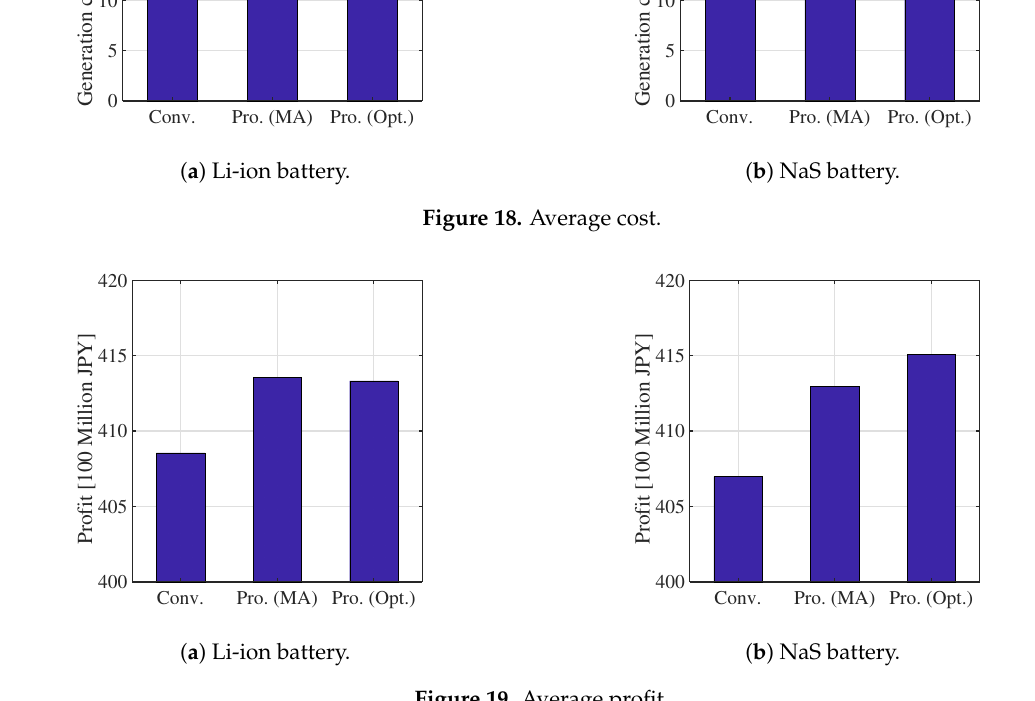
Figure 19. Average profit. Table 7. Average of simulation results. Conv. Pro. (MA) Pro.